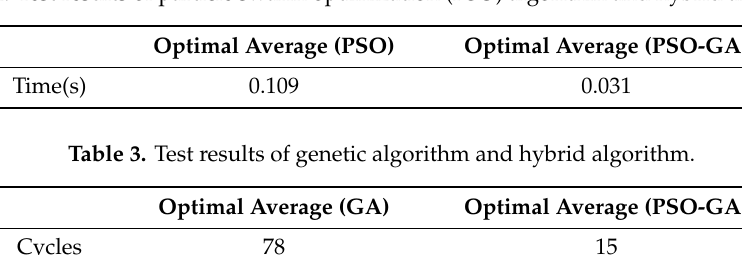
Table 2. Test results of particle swarm optimization (PSO) algorithm and hybrid algorithm.